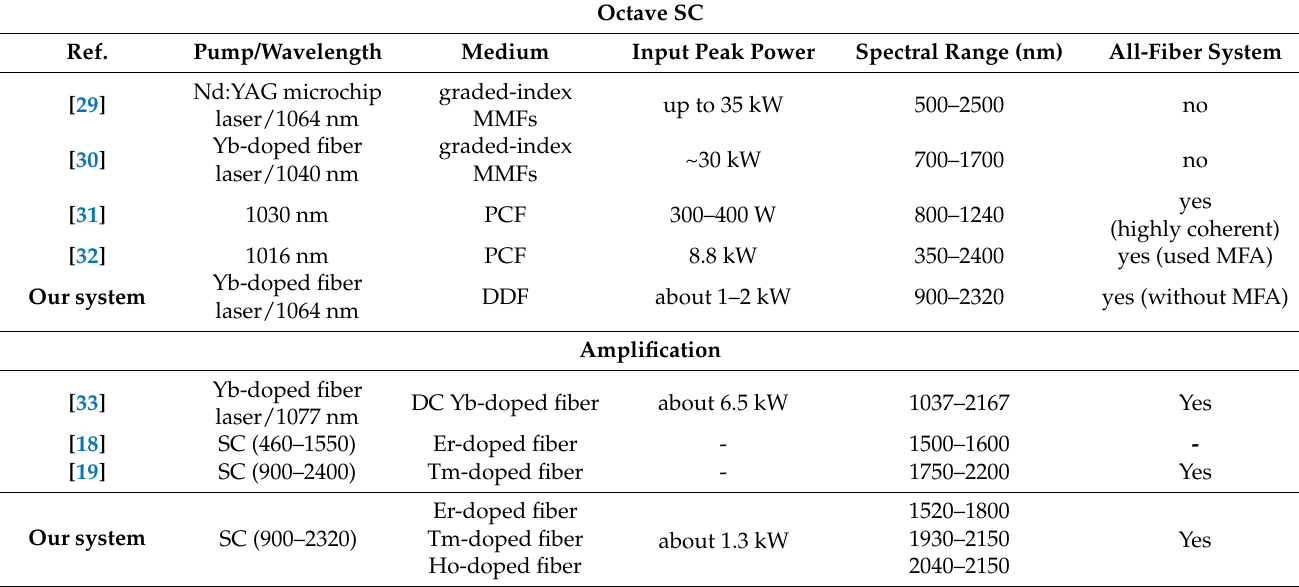
Table 2. Comparison of different SC generators and their partial